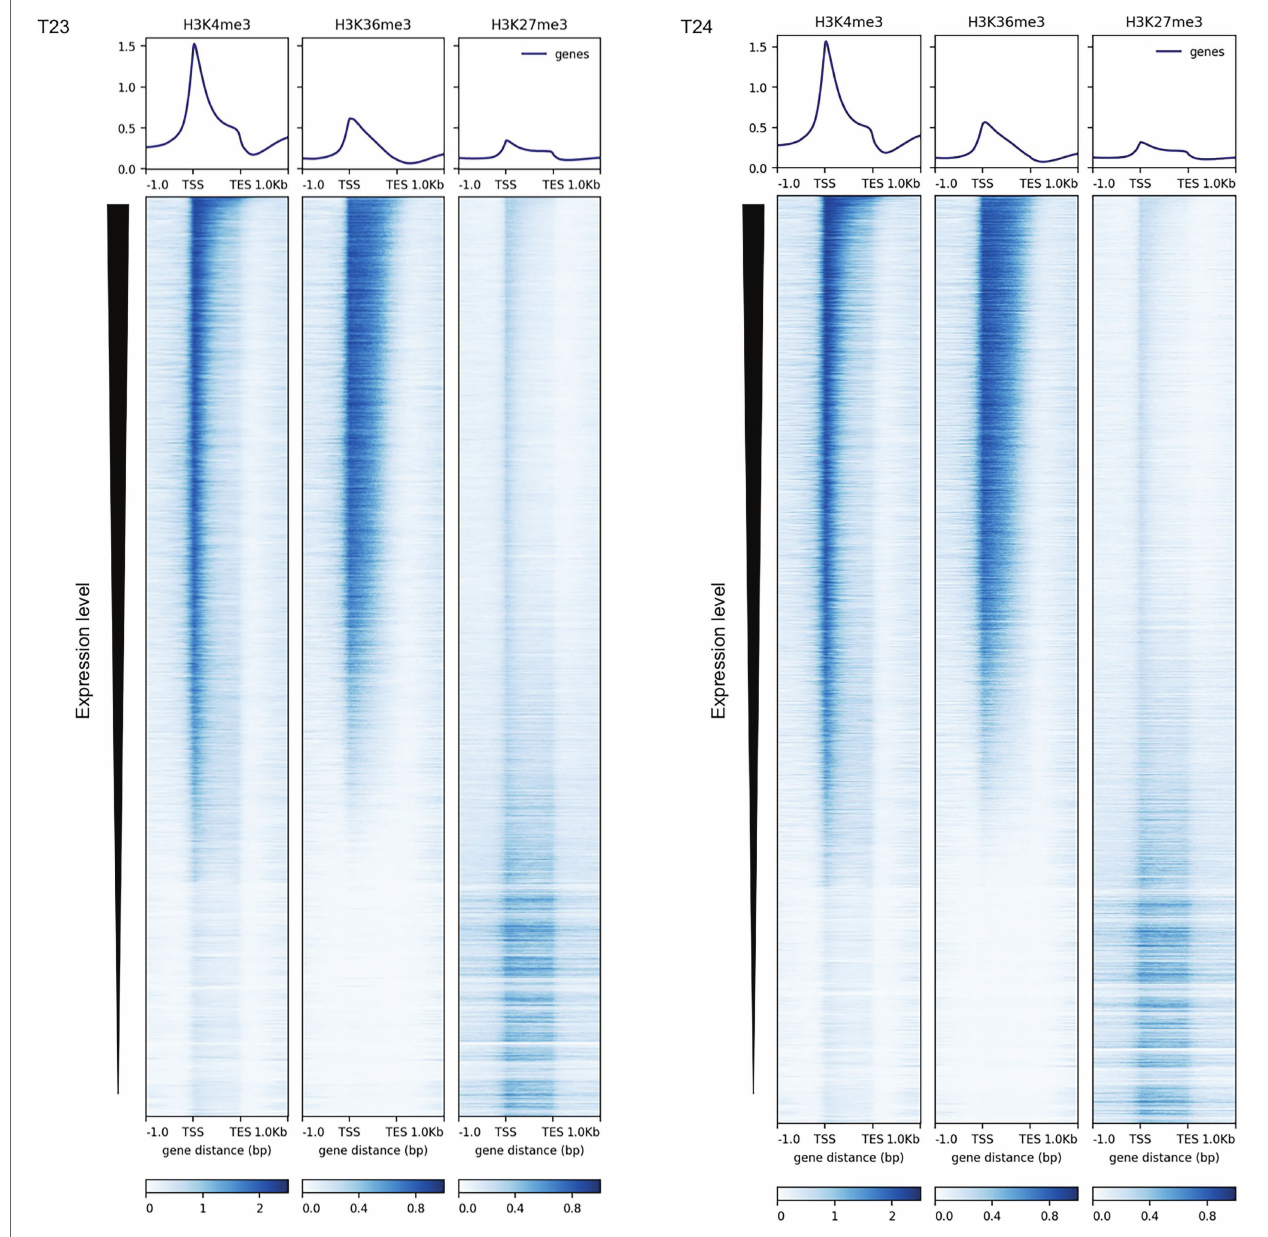
FIGURE 1 | Distribution of H3K4me3, H3K36me3, and H3K27me3 marks in the genic regions in RJKB-T23 (T23) and RJKB-T24 (T24). The deepTools version 3.1.3 is used for visualization